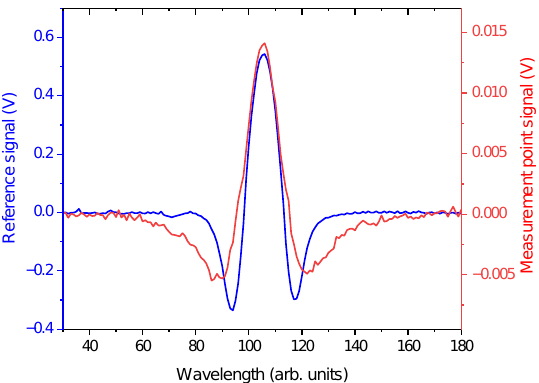
Figure 8. Wavelength Modulation Spectroscopy (WMS) signals from the reference cell (blue) and one of the measurement points along the stack